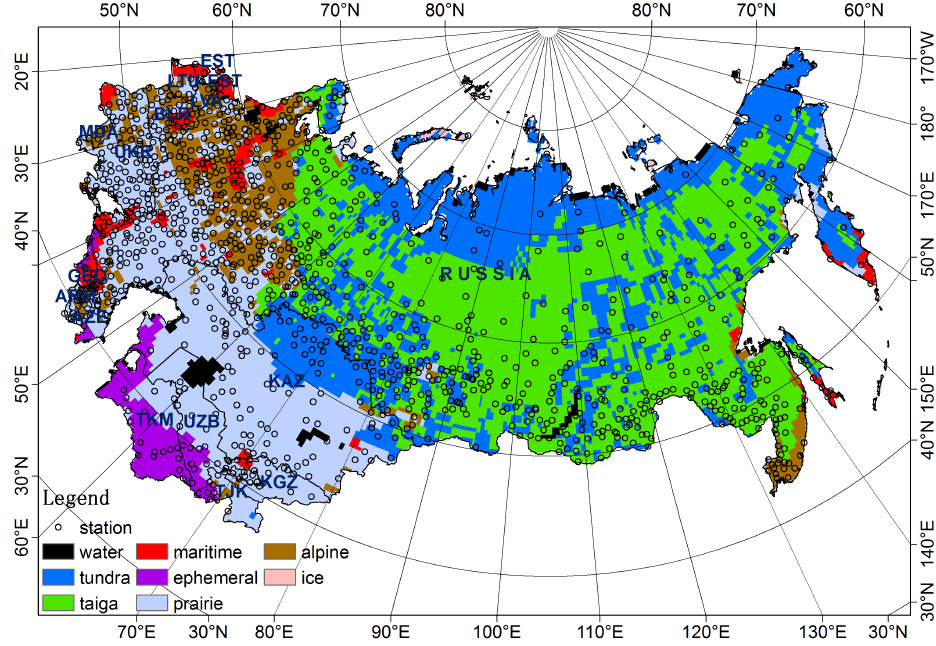
Fig. 1. Geographical locations and distribution of snow course stations and snow classes across the former USSR.